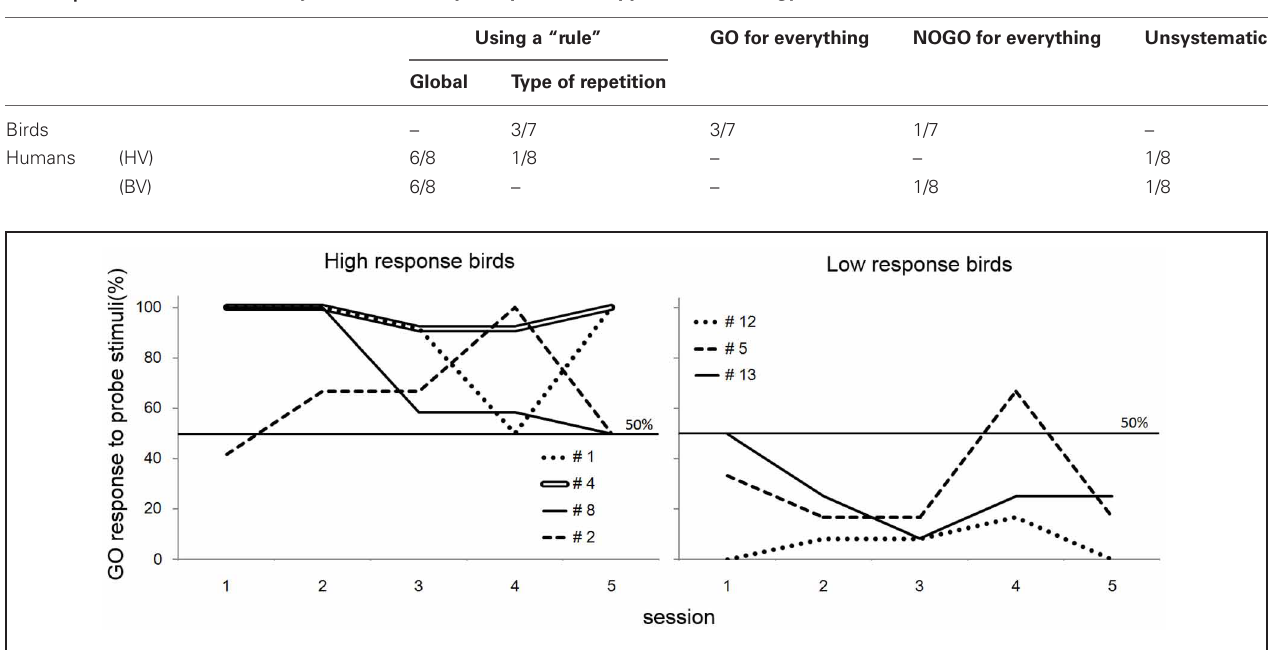
Table 1 | The numbers of bird subjects and human participants that applied each strategy in the task.